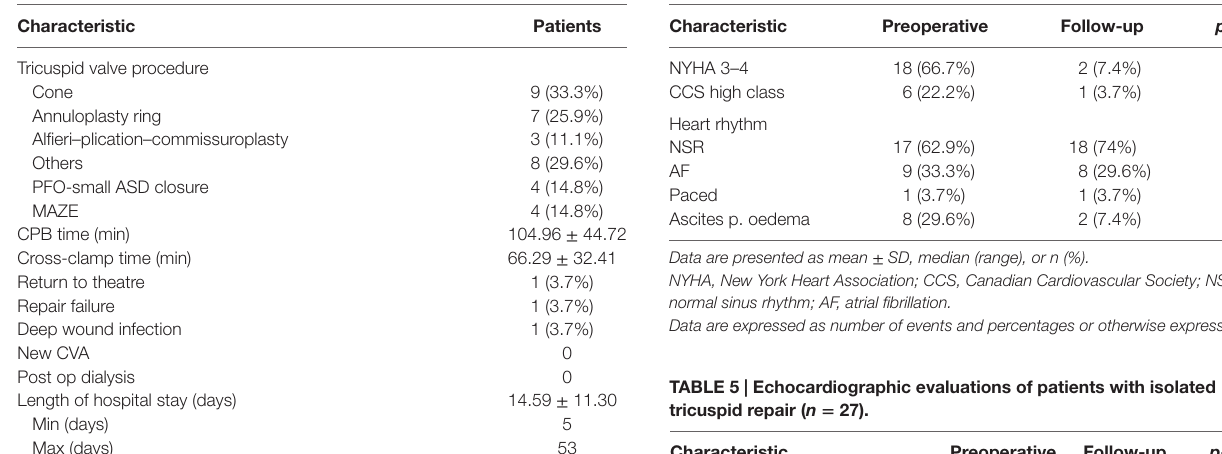
TaBle 3 | Operative and postoperative characteristics of patients with isolated tricuspid repair ( n =